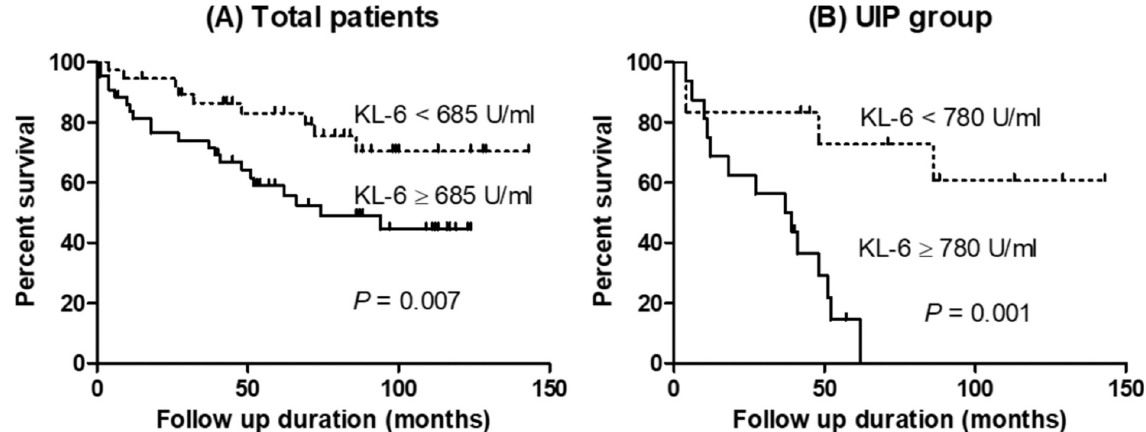
Fig 1. Comparison of survival curves according to KL-6 levels. (A) Total patients, (B) the UIP group. UIP, usual interstitial pneumonia.